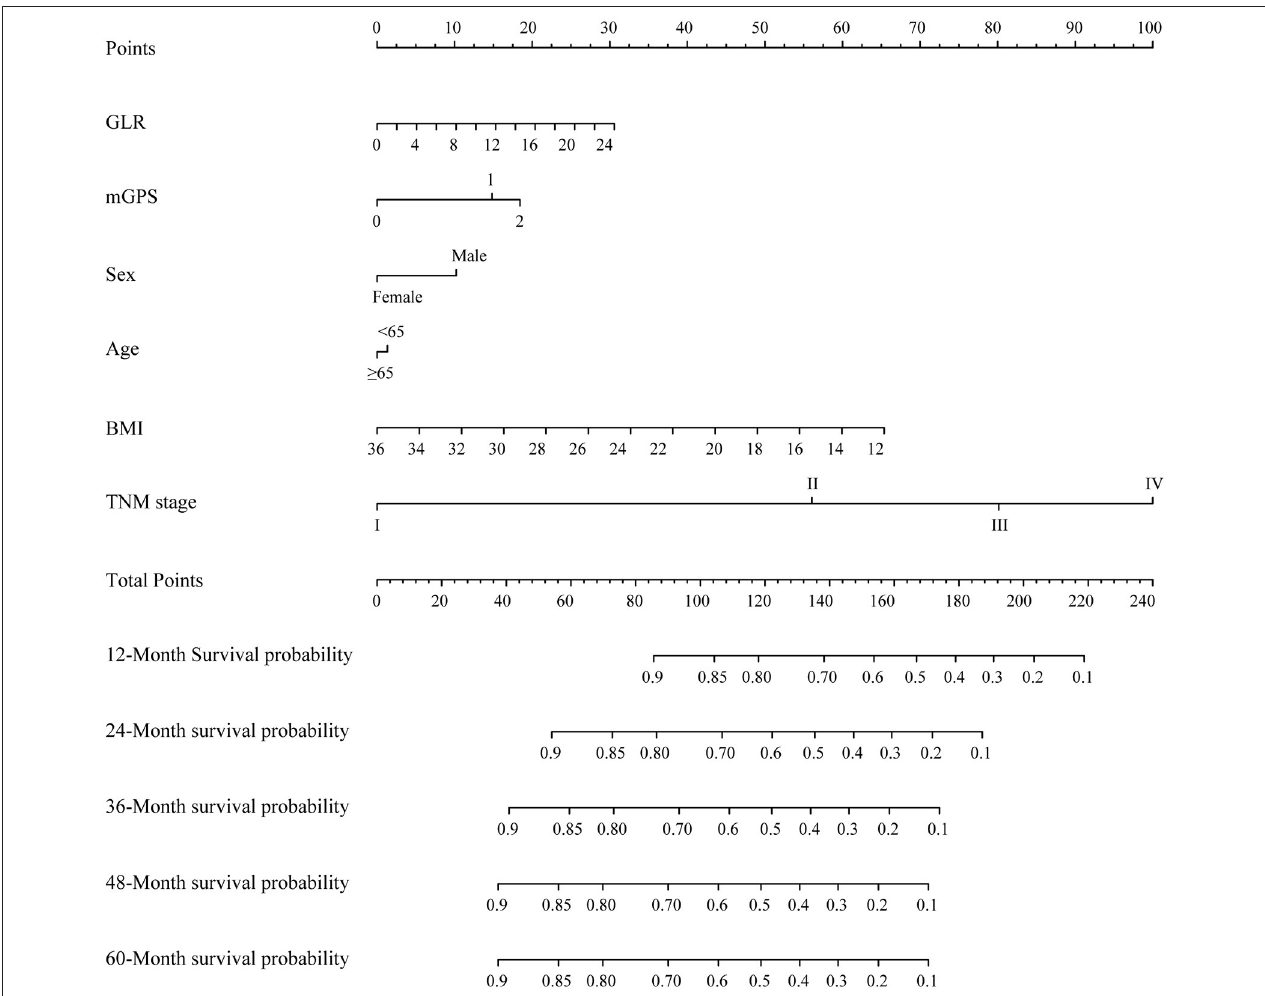
FIGURE 2 | A proposed nomogram for predicting median survival time and survival probability of patients with non-small cell lung cancer (NSCLC). To use the nomogram, a line is drawn upward to the Points axis to determine the number of points received for each variable. Sum of these points makes the total points. For total points, a line is drawn from the Total Points axis downward to the survival axes to determine the estimated median survival time and survival